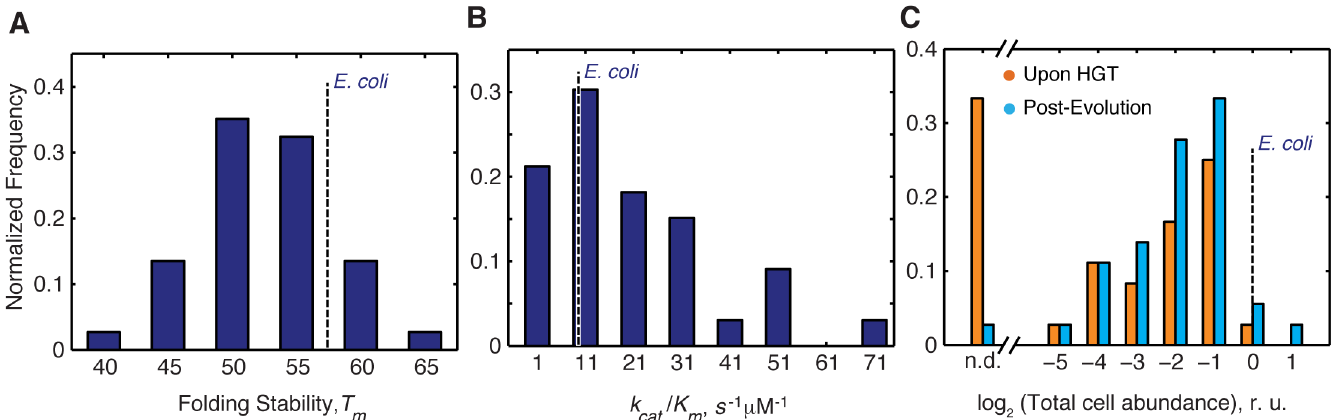
Fig 2. Distribution of molecular and cellular properties of orthologous DHFRs. A) Distribution of T m values of the purified DHFR proteins assessed by thermal unfolding in a Differential Scanning Calorimeter (see Materials and Methods). The proteins span wide range of stability between 42 – 63°C, as expected for mesophilic proteins, with ~80% of proteins having higher stability than E . coli DHFR. (see also S1 Table). B) Distribution of catalytic activity ( k cat / K M ) of the purified DHFRs (see Materials and Methods, and S1 Table). ~70% purified DHFR proteins were found to have activities that are comparable to or better than E. coli DHFR. C) Intracellular abundance (measured in total cell lysate) of DHFR before and after evolution experiment assessed by Western Blot with polyclonal anti-His antibodies (see Materials and Methods). Abundance is expressed relative to that of E . coli DHFR. Strains for which abundances were too low to be detected are denoted as n.d. After the evolution experiment, a large number of strains have detectable abundance (~97% compared to ~70% before evolution) (S1 Table and S5 Fig) Overall, there is a significant shift in the abundance distribution for all proteins after evolution experiment (KS p- value =